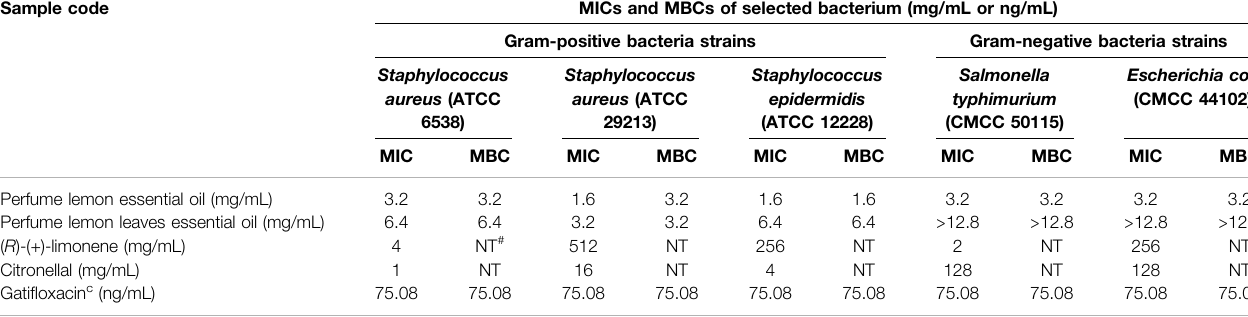
TABLE 3 | Biological Evaluation of the two essential oils expressed in MIC a and MBC b (mg/mL). Sample code